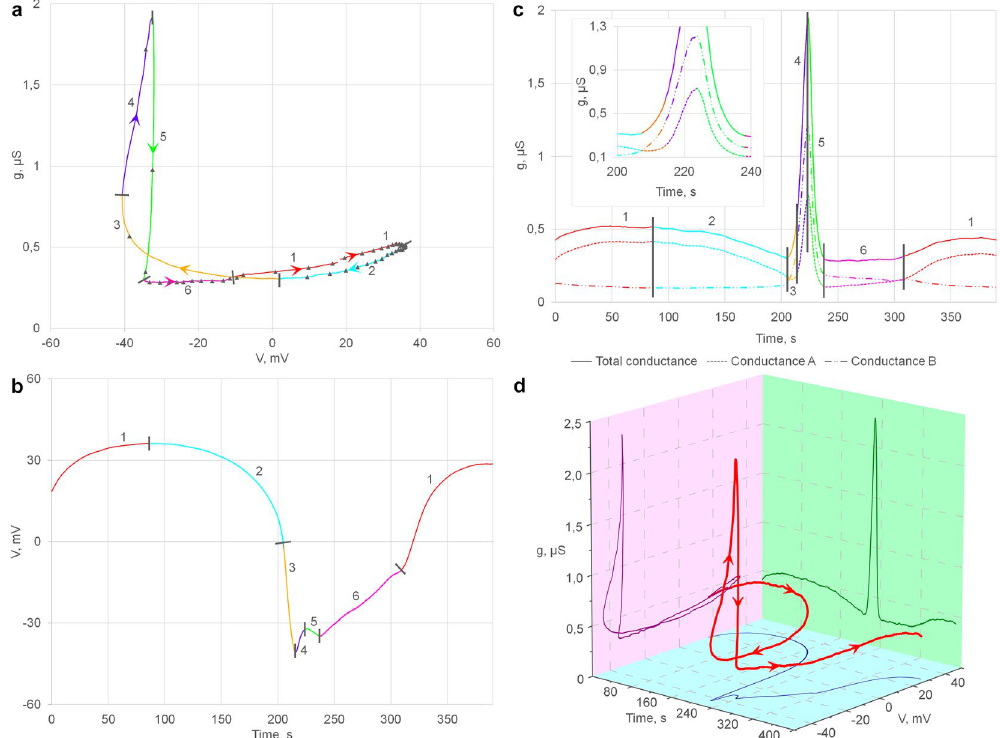
Figure 3. Gut cell membrane potential ( V ) and conductance ( g ) in DMP cycling ( a , b , c ) g(V) , V(t) , and g(t) dependences from one recorded DMP cycle. ( a ) In phase portrait dots are set in each 7 sec. The cycle is separated into 6 phases that differ in their V and g time course. ( c ) Membrane conductance (solid line) is divided in g a (dotted line) and g b (dash-dotted line) components according to the model (see text for details), time extended phases 3–5 are shown in inset. ( d ) g , V , t from a single gut cell DMP cycle were used to draw 3D trajectory plot (red). g(V) – magenta, g(t) – green and V(t) – blue are represented at projections. Arrows in ( a , d ) clarify the time course.